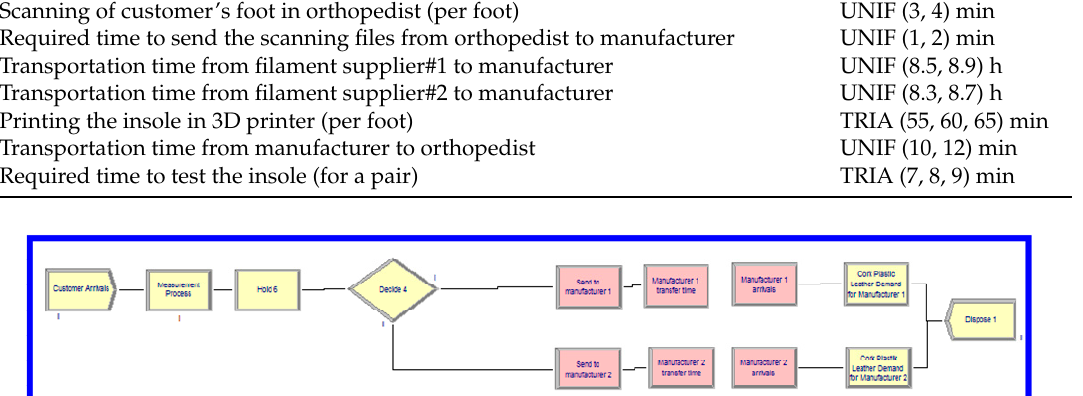
Figure 8. Shipping cork, plastic and leather from suppliers to the two manufacturers.